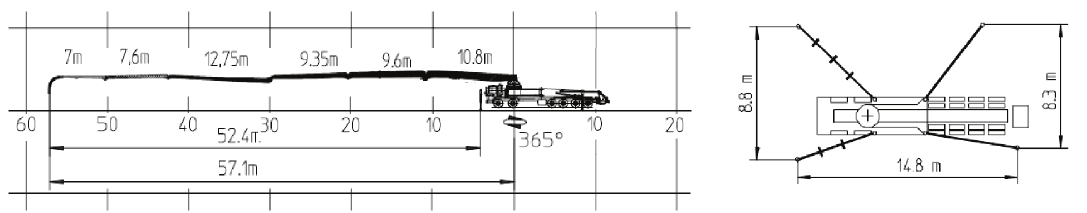
Fig. 7. Selected characteristics of the vehicle-mounted belt conveyor Telebelts TB 200, dimensions in meters [own study, on the basis of [20]]